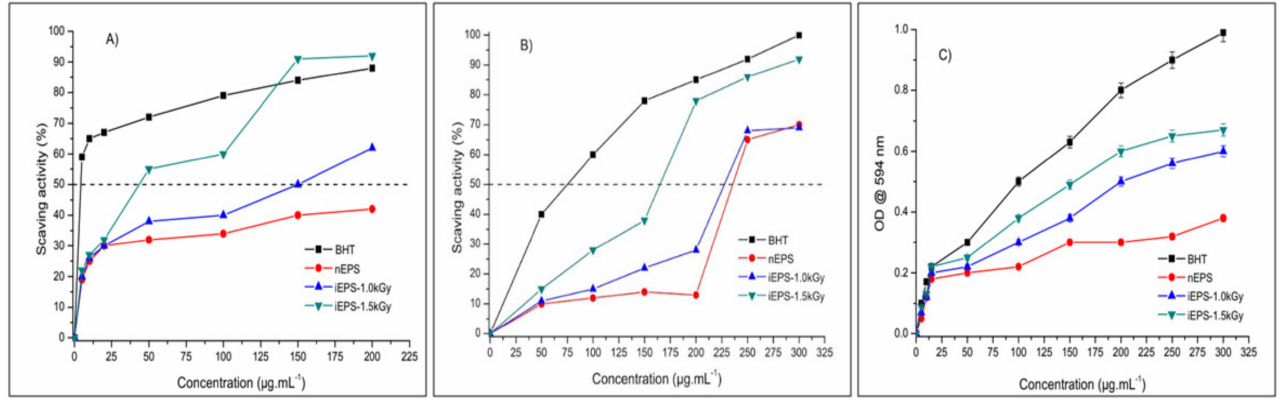
Figure 6. In vitro antioxidant activities of native exopolysaccharide (nEPS) and gamma-irradiated exopolysaccharide iEPS–1.0 and iEPS–1.5 kGy produced by H. desertis ( A ) DPPH scavenging activity, ( B ) ABTS scavenging activity, and ( C ) FRAP-Fe 3+ reducing power. BHT was used as a